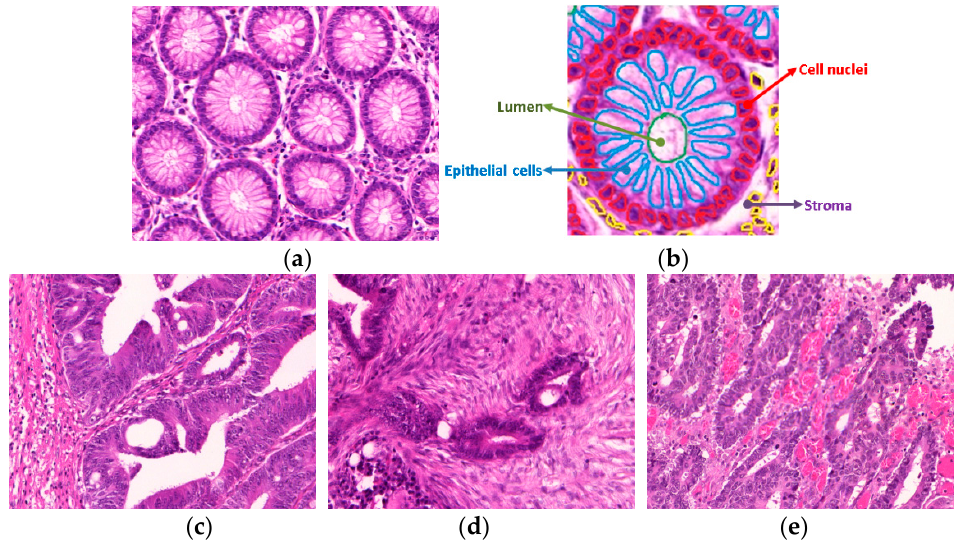
Figure 1. Example images: ( a ) Normal colon tissue, ( b ) detailed structure of a normal colon tissue; malignant colon tissue, ( c ) moderately differentiated, ( d ) moderately-to-poorly differentiated, and ( e ) poorly differentiated. These tissues have been stained with hematoxylin and eosin (H&E) stain; the hematoxylin stains cell nuclei purple, and eosin stains the extracellular matrix and cytoplasm pink, with other structures taking on different shades, hues, and combinations of these colors. ( a,c–e ) were captured at 20 × magnification, and ( b ) is one glandular region cropped from image ( a ).